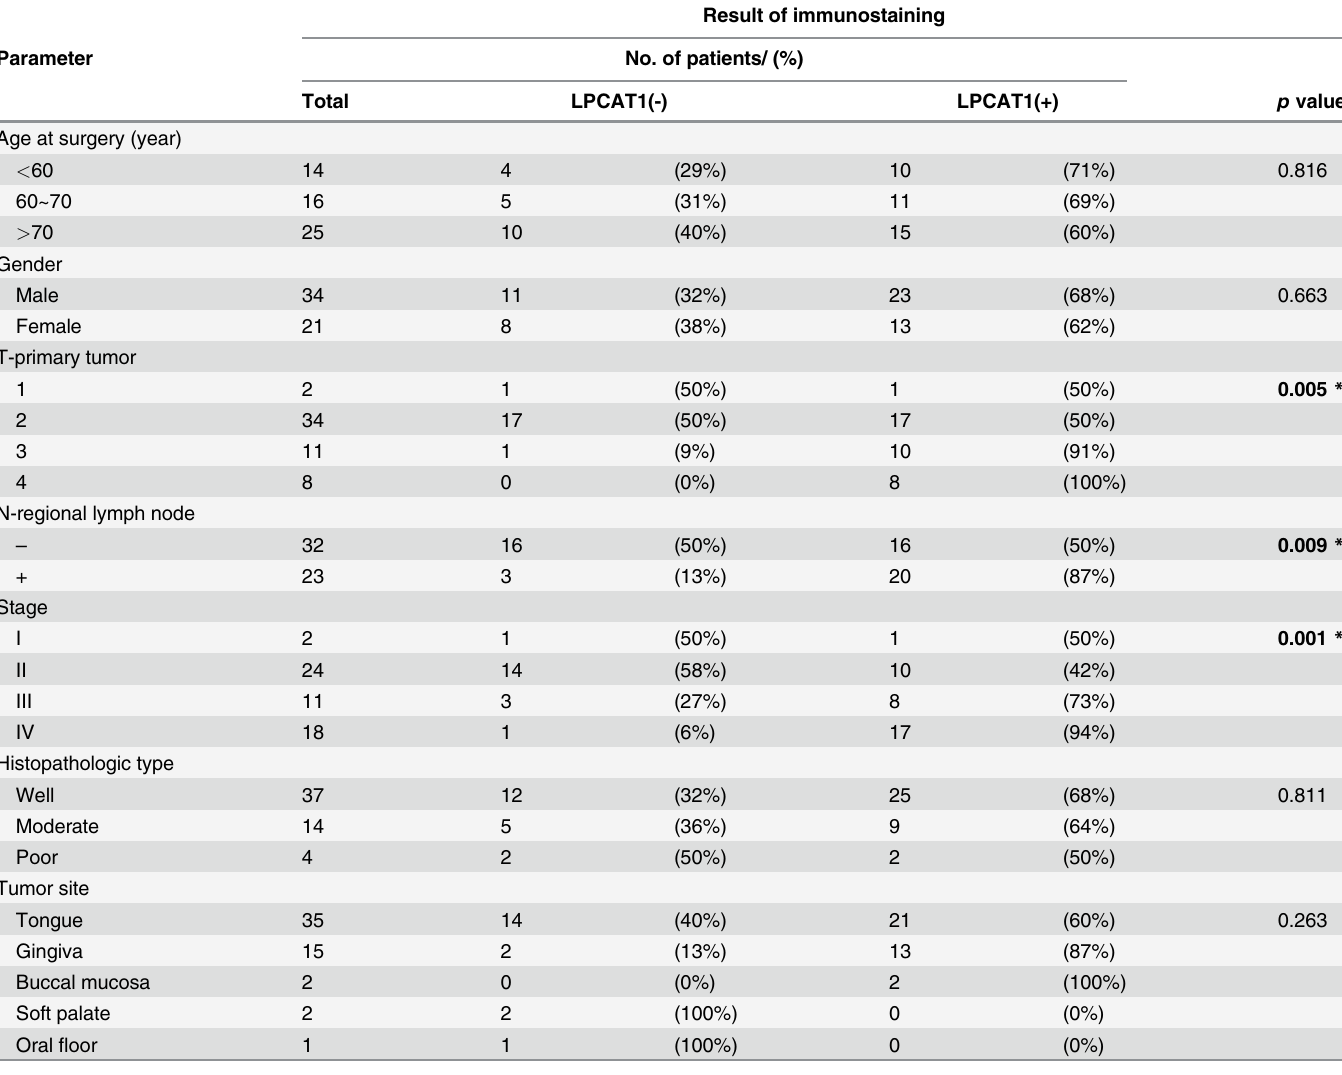
Table 1. Correlation between clinicopathological parameters of patients with OSCC and LPCAT1 protein expression.